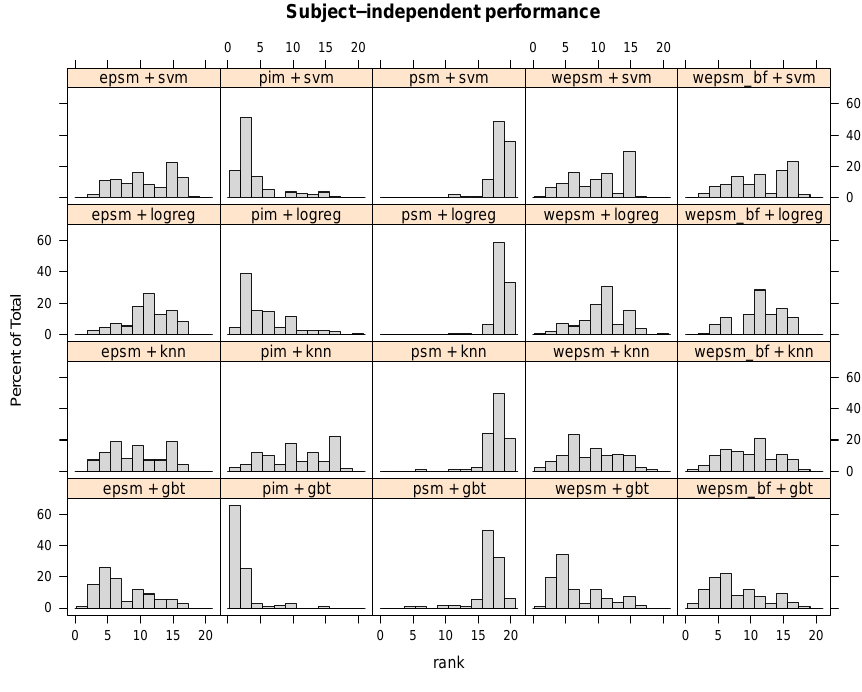
Figure 6. Distribution of the user-wise subject-independent ranks of each personalisation–generalisation approach + learning algorithm. PIM + GBT outperforms